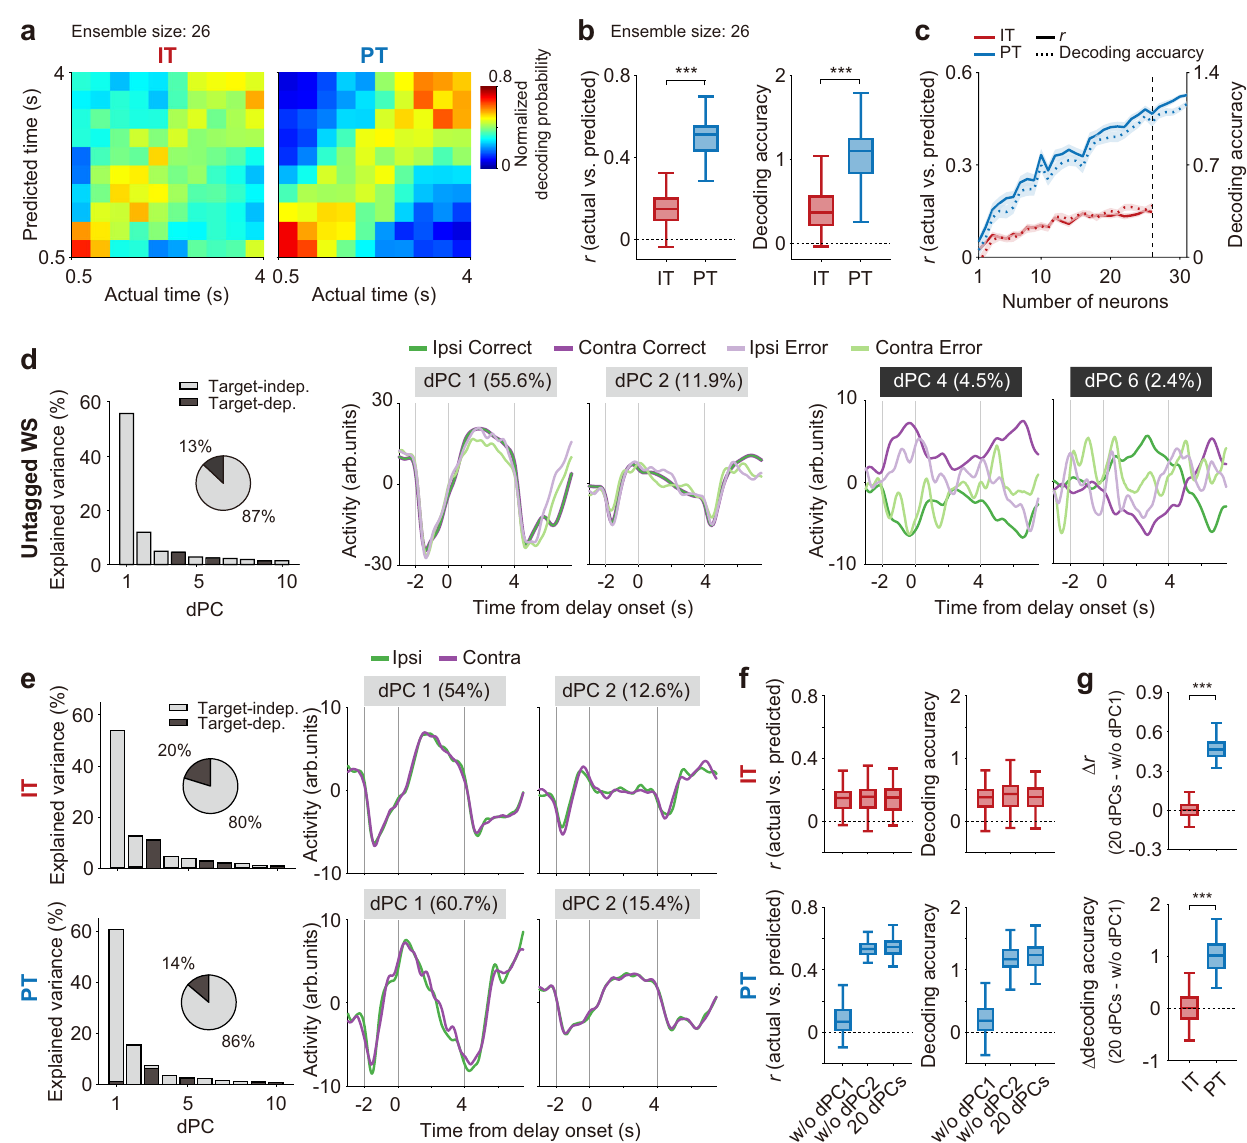
Fig. 6 PT neurons convey more temporal information than IT neurons. a – c Neural decoding of time using IT and PT neurons ( n = 26 and 31, respectively). a Mean normalized decoding probabilities (actual versus predicted bins) using 26 neurons. b Decoding performances of IT and PT neuronal ensembles ( n = 26 neurons; vertical dashed line in c). Left, correlation ( r ) between the actual and predicted bins; right, decoding accuracy (see Methods). *** p < 0.001 ( t -test). c Decoding performance as a function of ensemble size. Shading, SEM across 100 decoding iterations. d Left, variance in neural activity explained by individual dPCs for untagged WS neurons ( n = 365 recorded in the sessions with ≥ 2 error trials for both targets). Gray and black denote target- independent and target-dependent dPCs, respectively (see Methods). The pie chart shows the total variance explained by the target-dependent and target- independent dPCs. Middle and right, time courses of the top two target-independent (middle) and target-dependent (right) dPCs. Same color code as in Fig. 4 (green and purple for the ipsilateral and contralateral targets, respectively; saturated and soft colors, correct and error trials, respectively). e Left, variance explained by individual dPCs for IT ( n = 26) and PT ( n = 31) neurons. Right, dPC1 and dPC2. f Temporal decoding using the fi rst 20 dPCs compared with those lacking dPC1 (w/o dPC1) or dPC2 (w/o dPC2). g The amount of decoding lost by excluding dPC1 (upper, correlation; lower, decoding accuracy). *** p < 0.001 ( t -test). Boxplots ( b , f , and g ) show median, interquartile range, and maximum and minimum within 1.5 interquartile range. Only correct trials were analyzed for IT and PT neurons ( a – c and e – g ), and both correct and error trials were analyzed for untagged WS neurons ( d